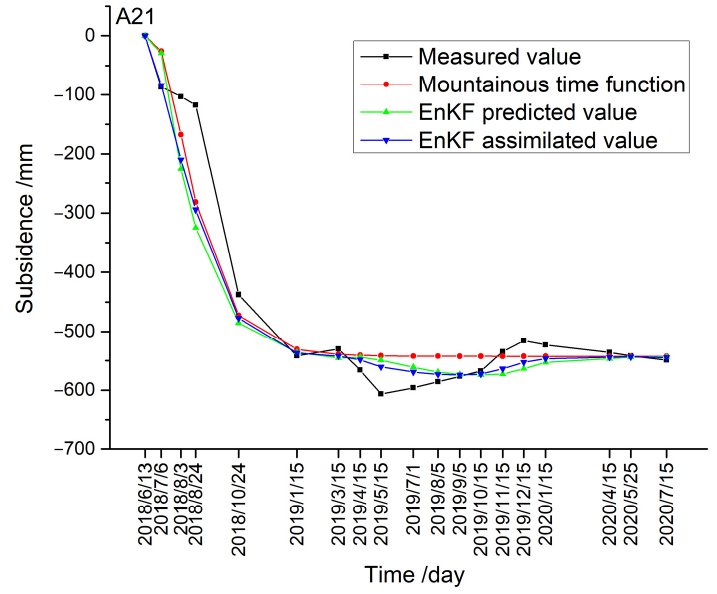
Figure 5. Subsidence curves of A21 using different methods.